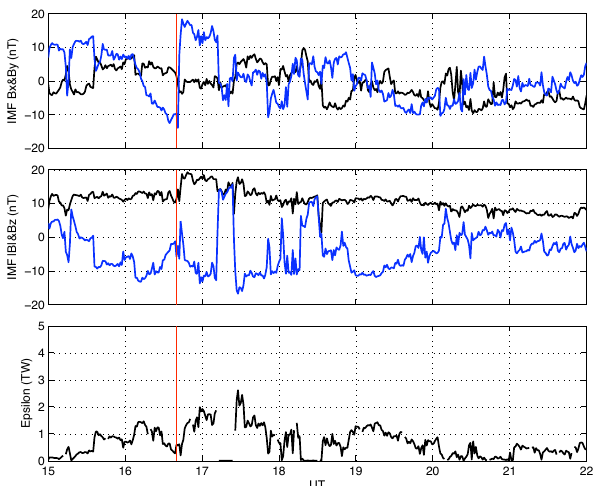
Fig. 10. IMF and solar wind parameters for substorm 2 in the main phase of the mini-storm. From the top to the bottom: (1) IMF B X (black) and B Y (blue), (2) IMF magnitude (black) and B Z compo- nent (blue), and (3) epsilon parameter. The vertical red line marks the substorm onset time. These data are propagated to the magne- topause (at 10 R E ) with the average solar wind velocity.